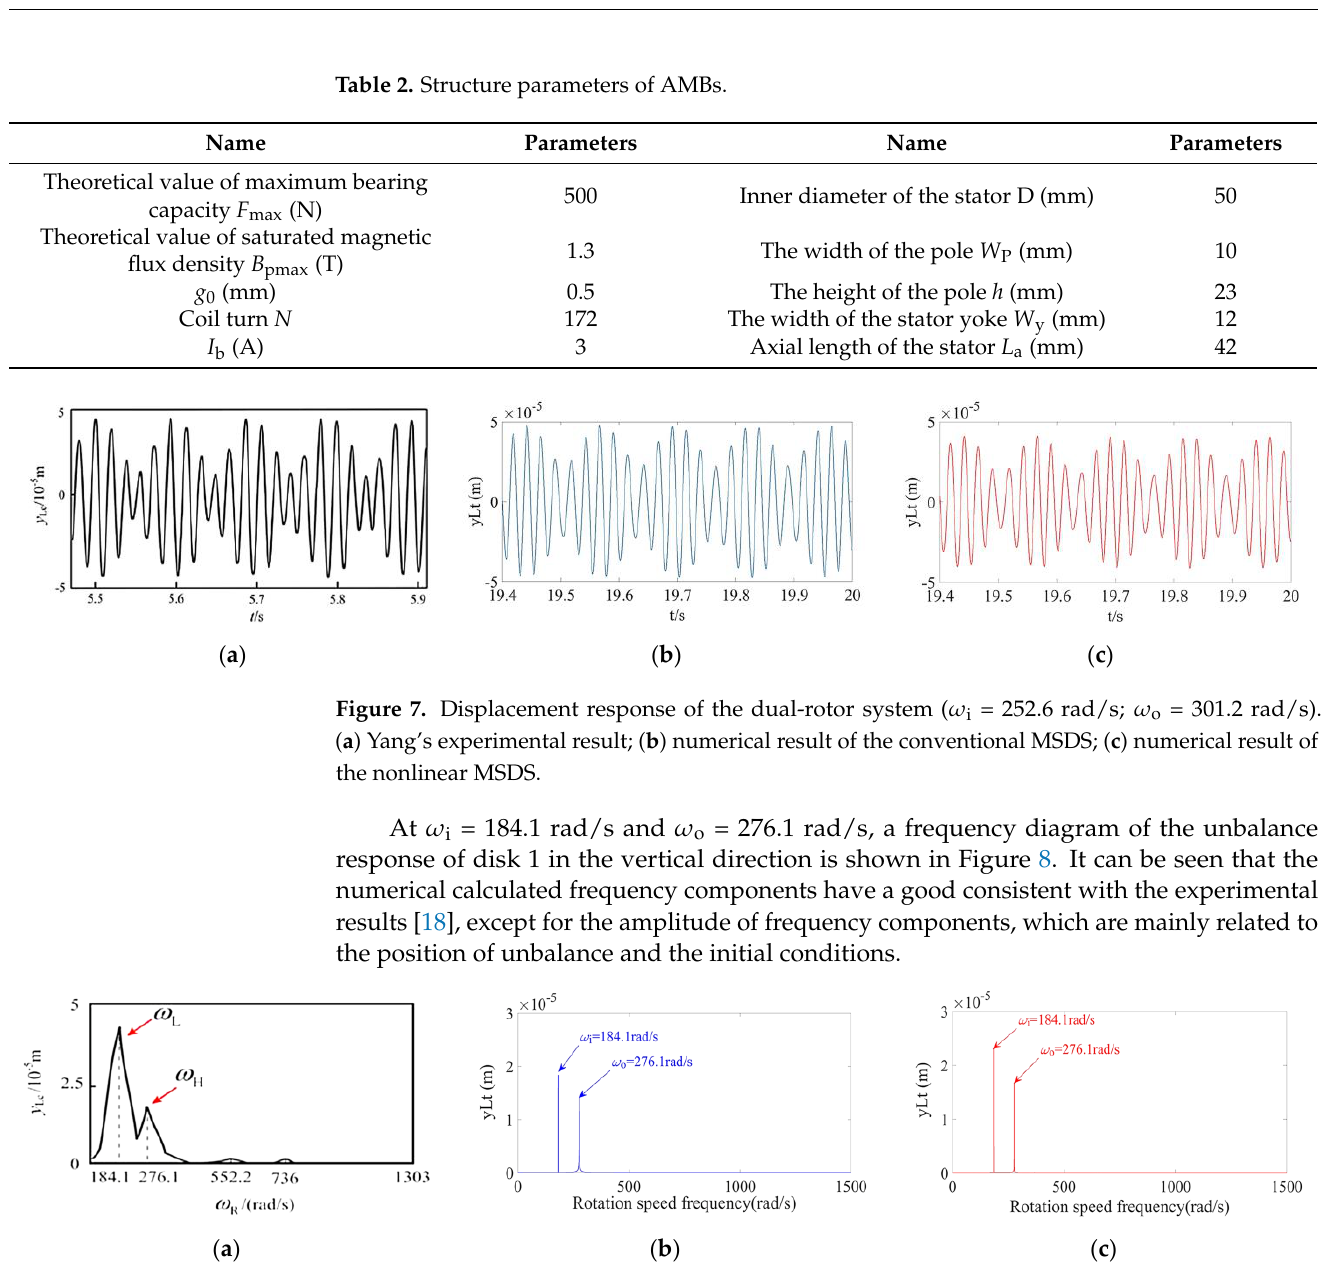
Figure 8. Displacement response of the dual-rotor system ( ω i = 184.1 rad/s; ω o = 276.1 rad/s). ( a ) Yang’s experimental result; ( b ) numerical result of the conventional MSDS; ( c ) numerical result of the nonlinear MSDS.